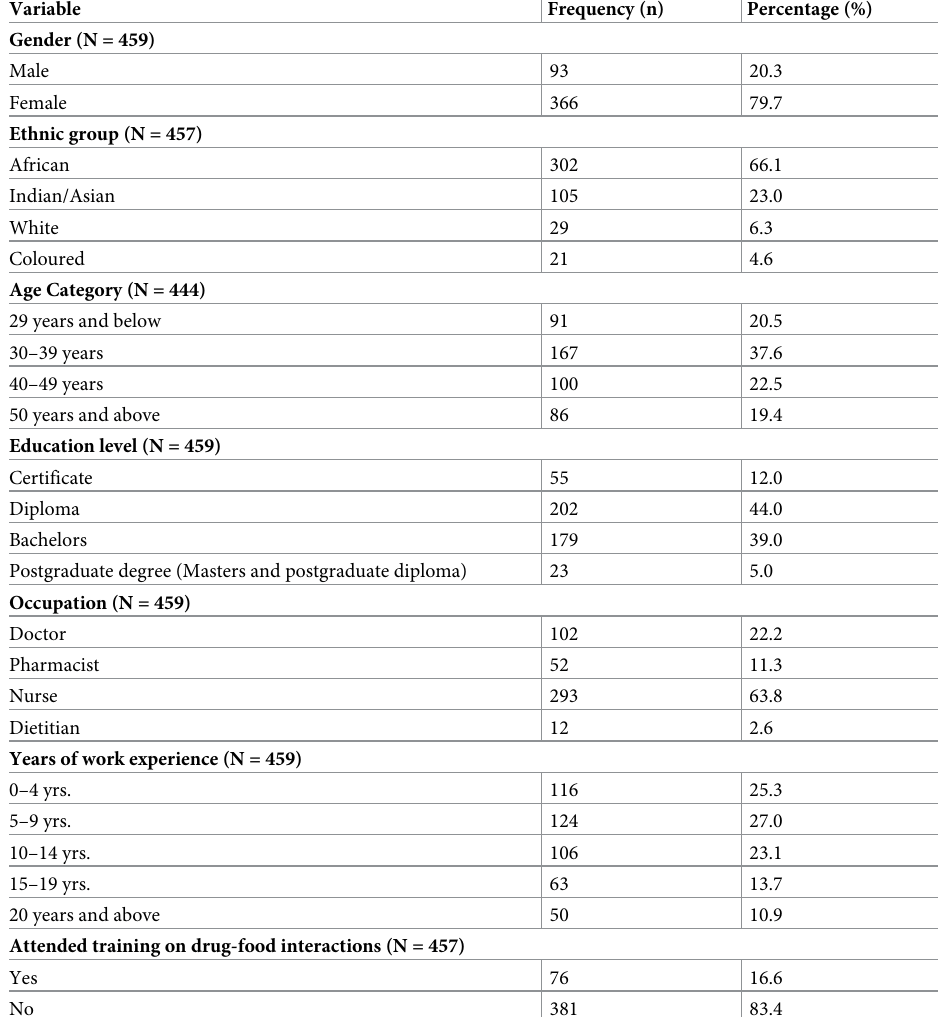
Table 1. Demographic and general characteristics of the healthcare